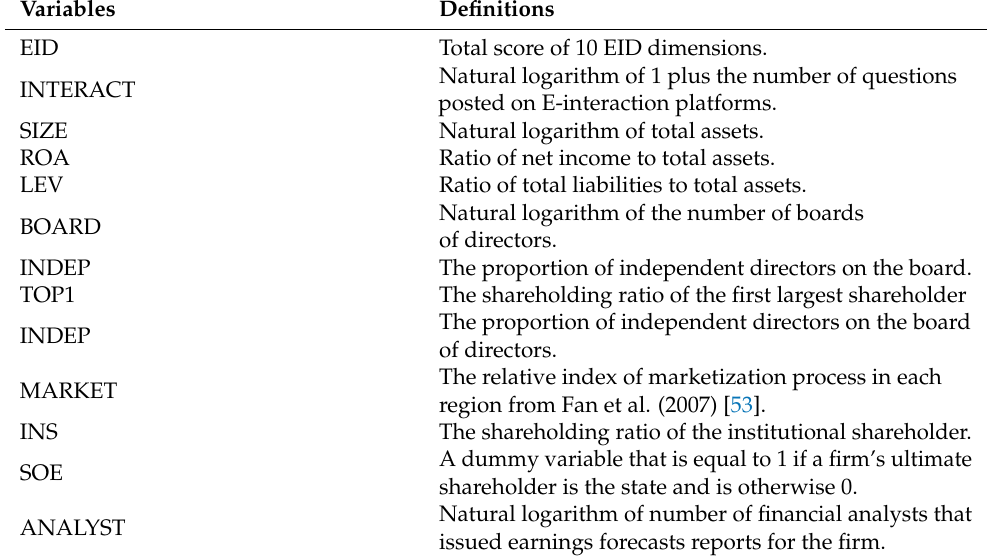
Table 1. Variable